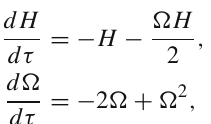
for all λ . The phase portrait of the system (4.6) indicates that all solutions with initial values (cid:4) 0 < 2 (this corresponds to an dS dust fluid) and H 0 arbitrary, asymptotically approach the node ( 0 , 0 ) (that is a static, empty dS bulk), see Fig.